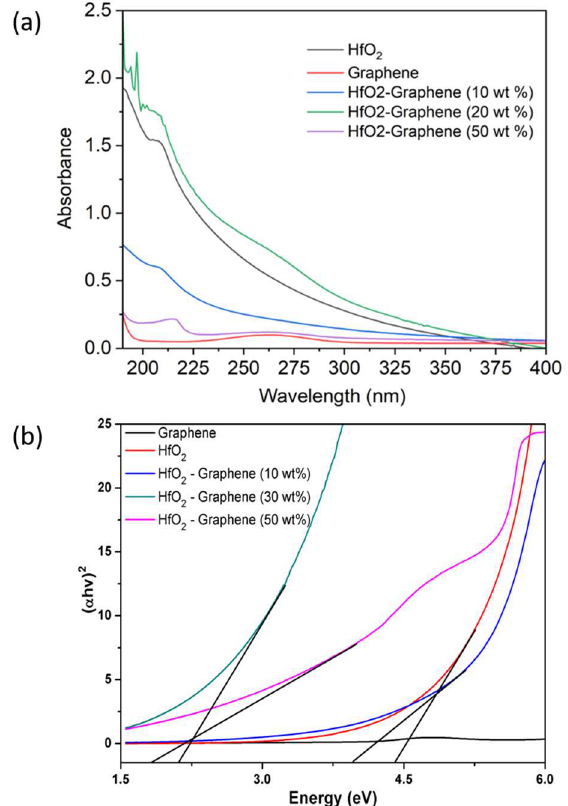
Figure 6. ( a ) UV-Visible absorption spectra of HfO 2 nanoparticles, graphene, and HfO 2 —graphene (10, 30, and 50 wt%) nanocomposites, ( b ) Variation of (αhν) 2 with photon energy for graphene and HfO 2 and HfO 2 —graphene (10, 30, and 50 wt%) nanocomposites.